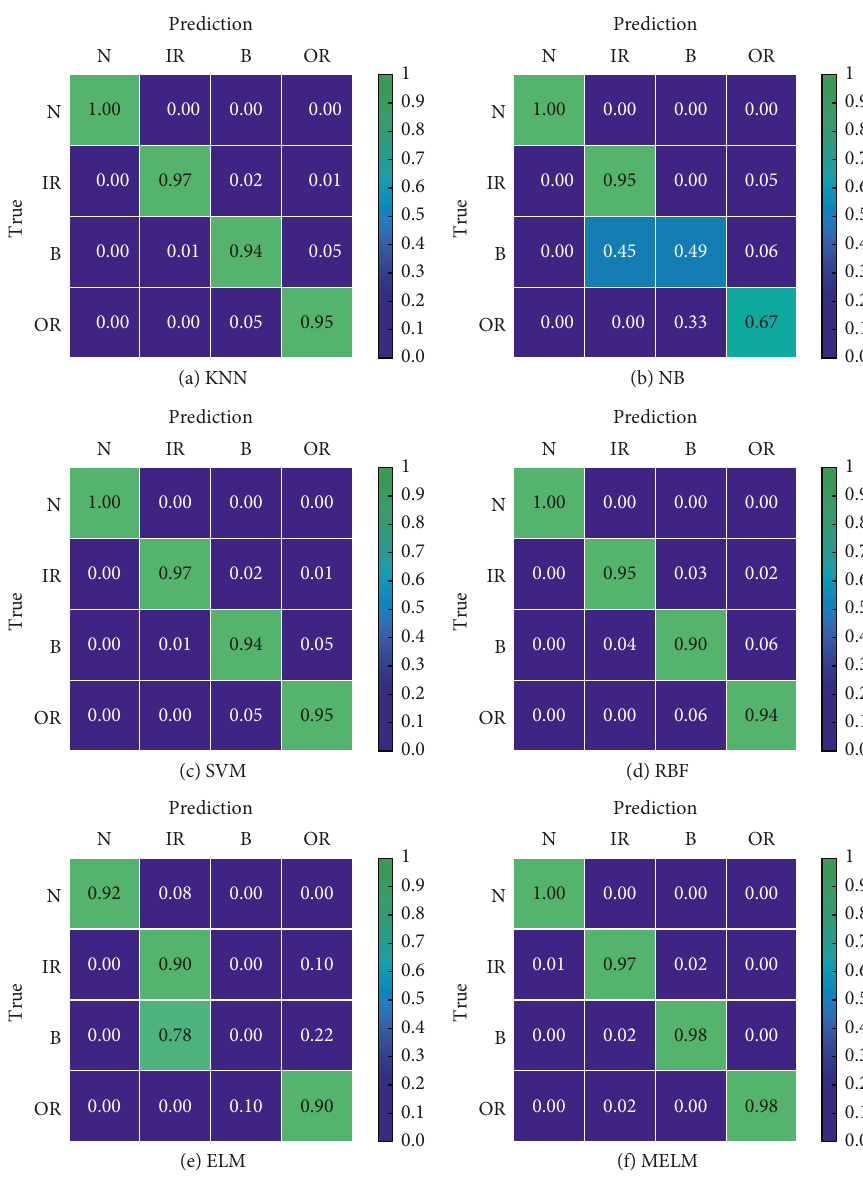
Figure 15: Bearing fault diagnosis of six different